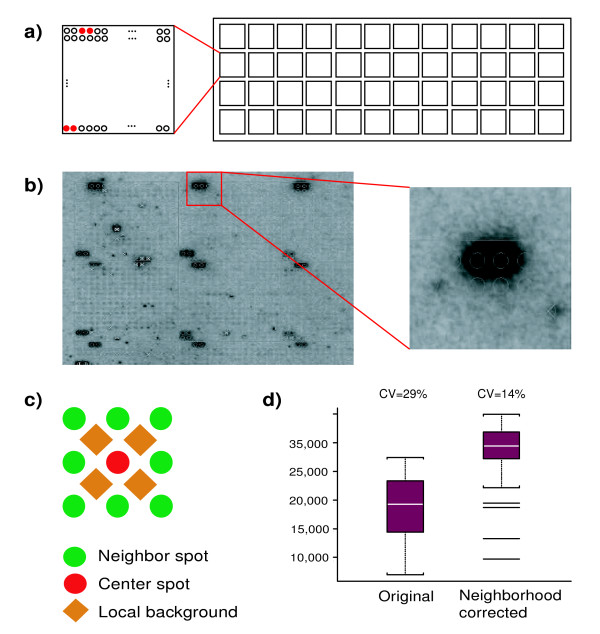
Background correction. (a) The test slide has an array of 4 by 12 blocks consisting of 2 pairs of positive controls (PKA) and random yeast proteins in the remaining spots in each block. (b) The autophosphorylation experiment showed typical bleeding problems in positive control spots. (c) Signal for one spot is measured as foreground minus local background intensity; therefore, artifacts in background add noise to the signal intensity. (d) Comparison of signal distributions of PKA spots before and after background corrections. The median of PKA signals is enhanced by 53% and the variance among the PKA spots is decreased by 41%.